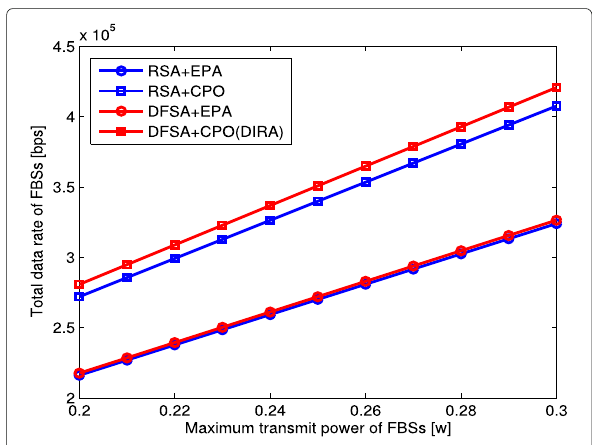
Fig. 8 Total data rate of FBSs vs. P max